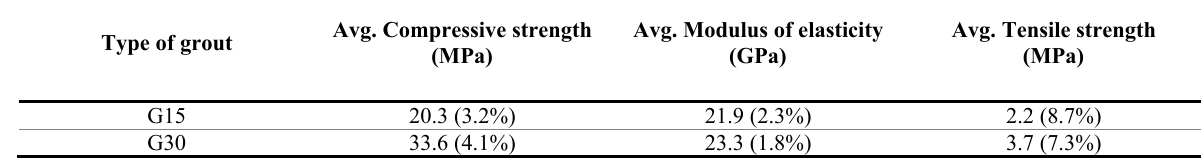
Table 3. Properties of the grouts.